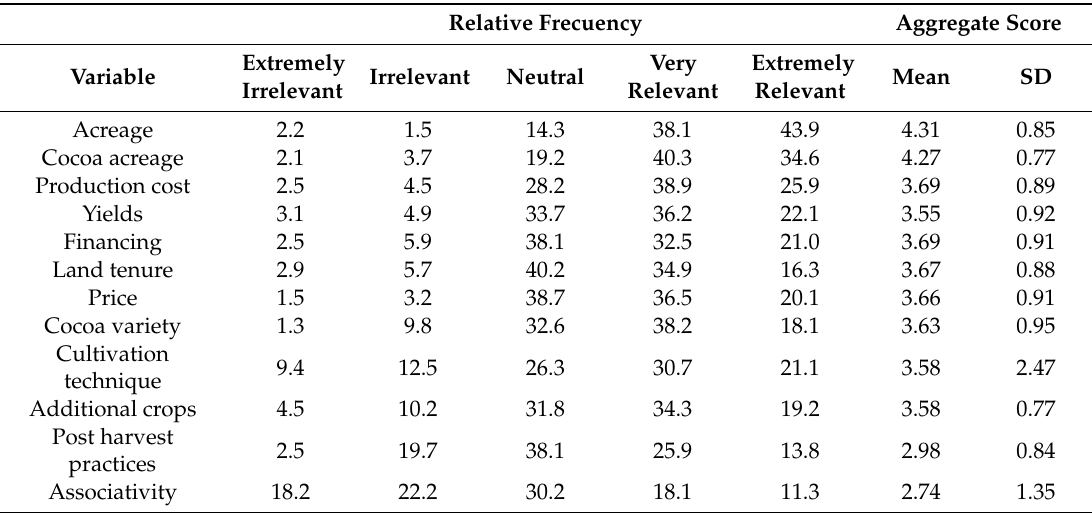
Table 5. Producers’ perception of the relative importance of productive performance aspects.